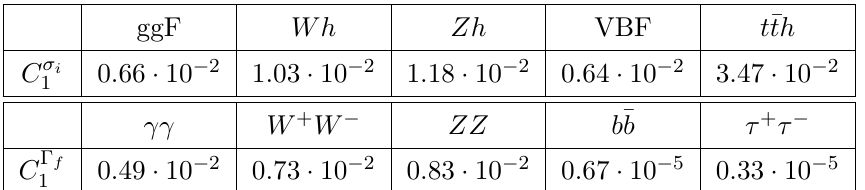
Table 2. Values of the process-dependent coefficients C σ i or obtained from [19, 20, 22] and the coefficients C σ i